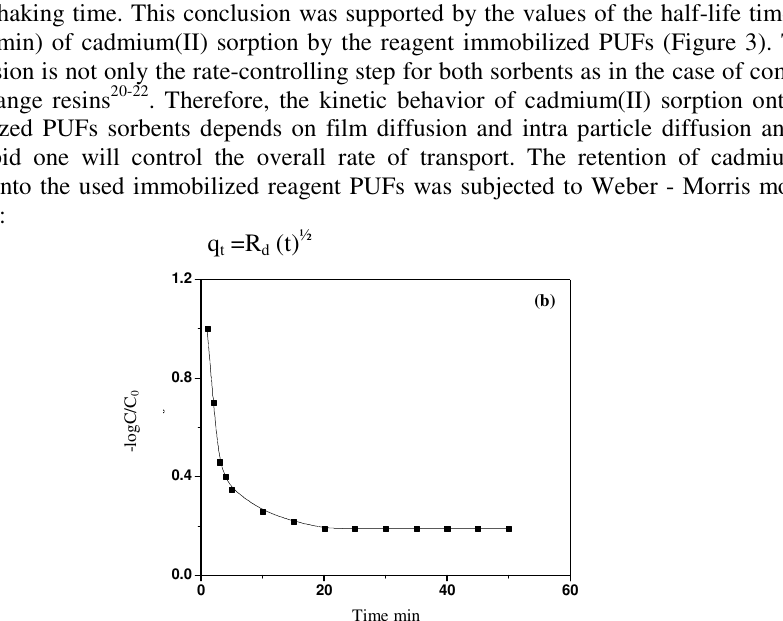
is the t versus time were found t were found equal d for immobilized d